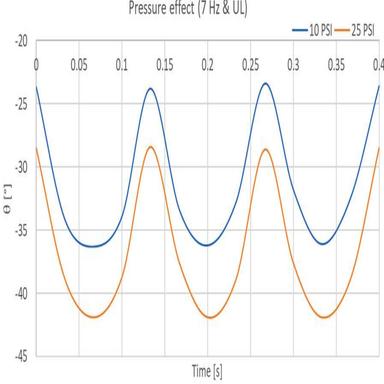
Rotation angle – pressure effect (7 Hz & UL).